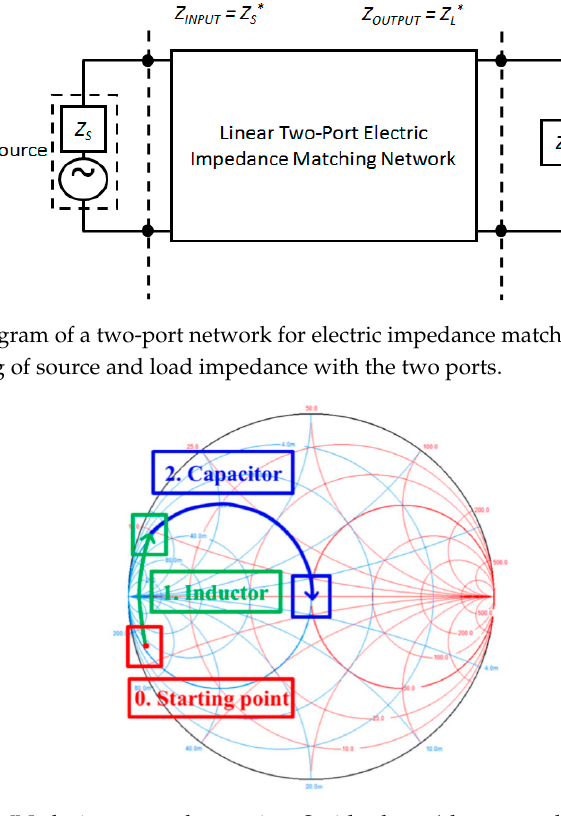
Figure 2. The EIMN design procedure using Smith chart (shown at the left) where the input electrical impedance of the ultrasonic transducer is moved toward the center of the Smith chart by appropriately adjusting the inductor and capacitor component values and topology, at the center frequency. Reproduced with permission from Reference [41], Copyright Elsevier,